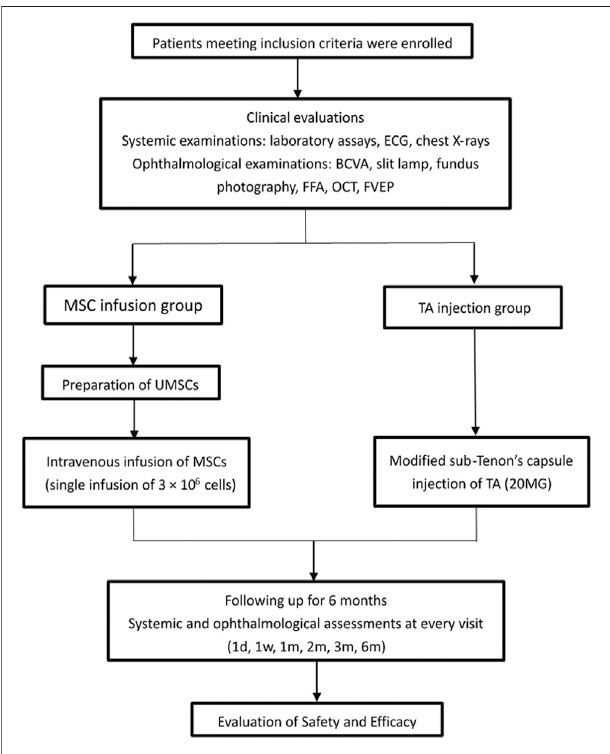
FIGURE 1 | Flow chart of the